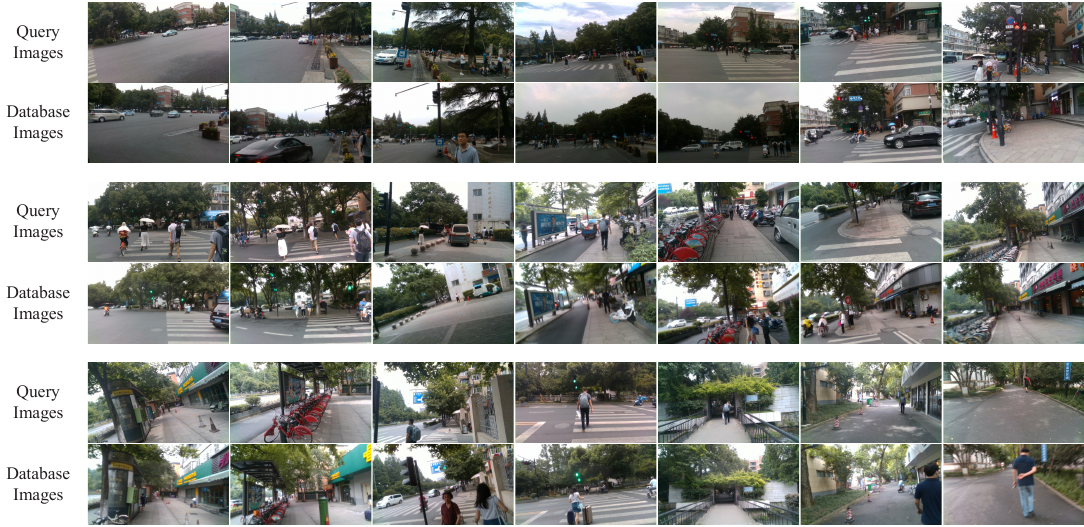
Figure 21. The localization results of a 1000-m trajectory, which is the red route in Figure 20a. Visual localization is achieved under the circumstances of viewpoint